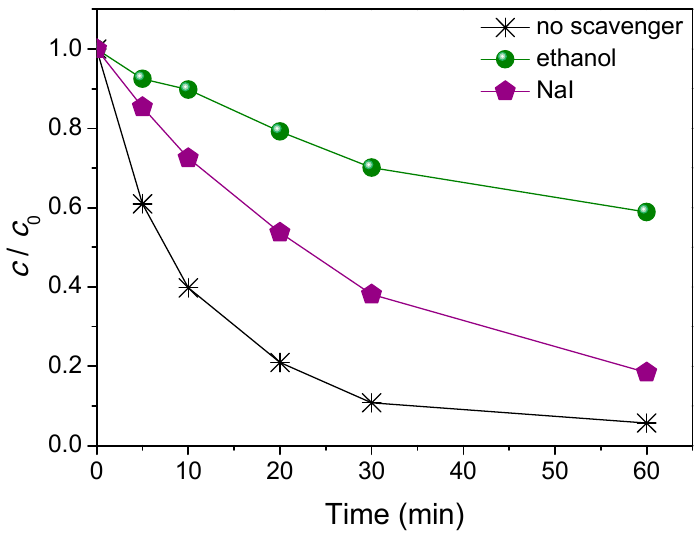
Figure 7. The effect of ethanol and NaI (3.0 mmol/L) on the kinetics of photocatalytic degradation of AMI (0.0300 mmol/L) using ZnO (1.0 mg/mL) and solar radiation.